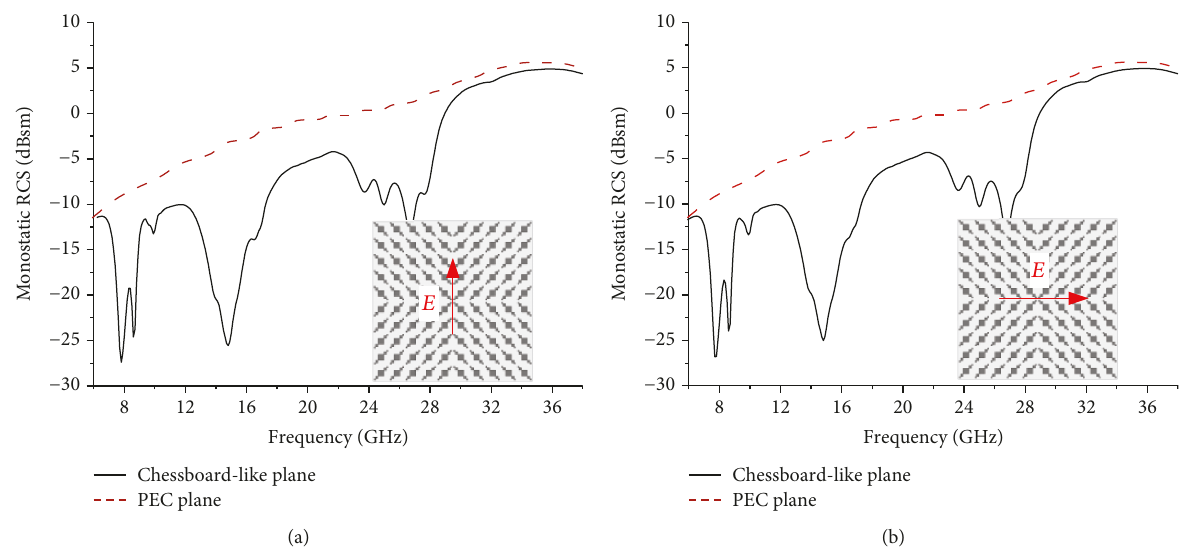
Figure 7: Monostatic RCS of the chessboard-like plane and PEC plane for normal incidence: (a) x -polarized incidence; (b) y -polarized incidence.